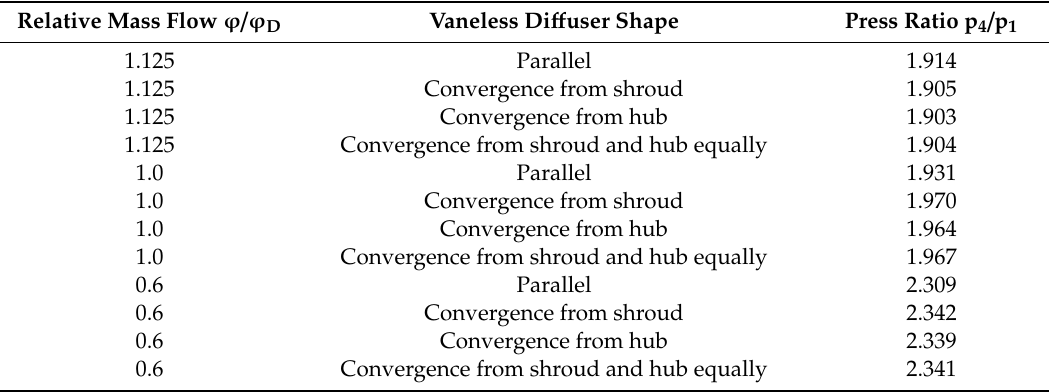
Table 3. Total-to-total pressure ratio of centrifugal compressor.